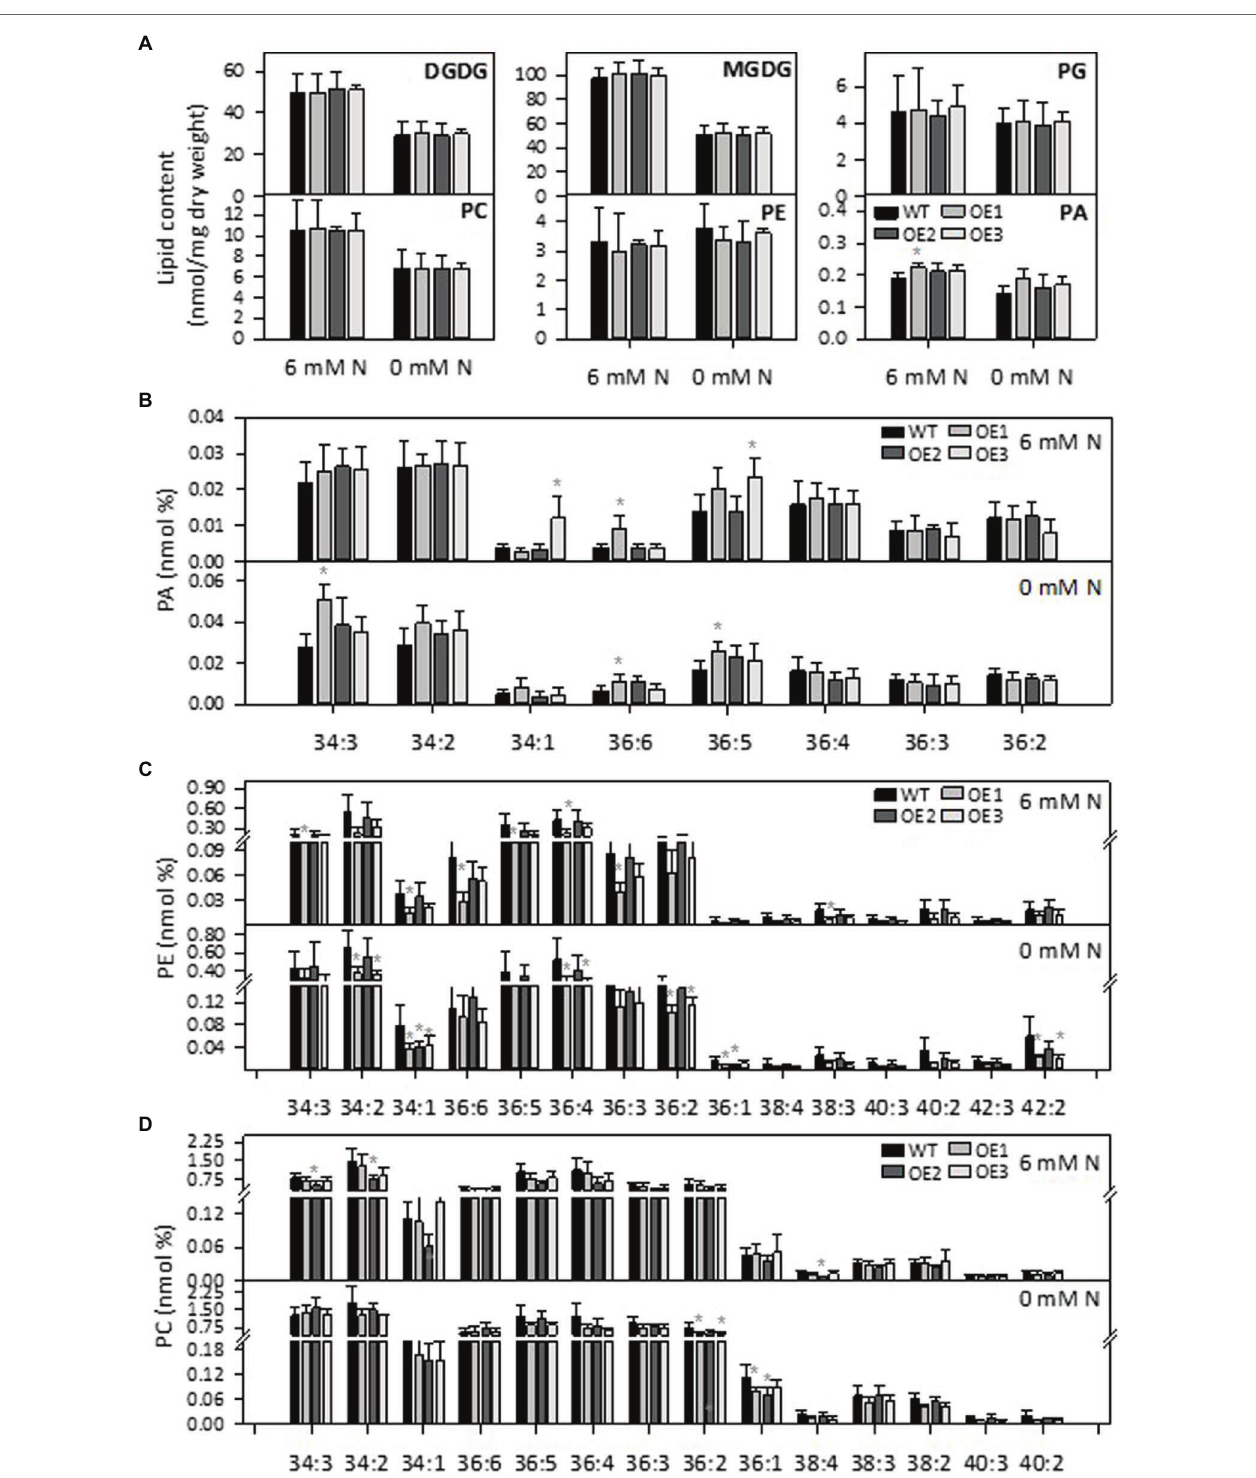
FIGURE 4 | Effect of PLD ε alterations on lipid content and composition. (A) Lipid contents in leaves of WT and AtPLD ε OE soybean. Two-week-old soybeans grown on nitrogen rich liquid medium were transferred to nitrogen rich or free liquid medium for 7 days. The values are means ± SD of five biological replicates. *Denotes statistical significance at p < 0.05 compared with WT as determined by one-way ANOVA (Duncan’s multiple range test). PA (B) , PE (C) , and PC (D) molecular species in leaves of WT and AtPLD ε OE